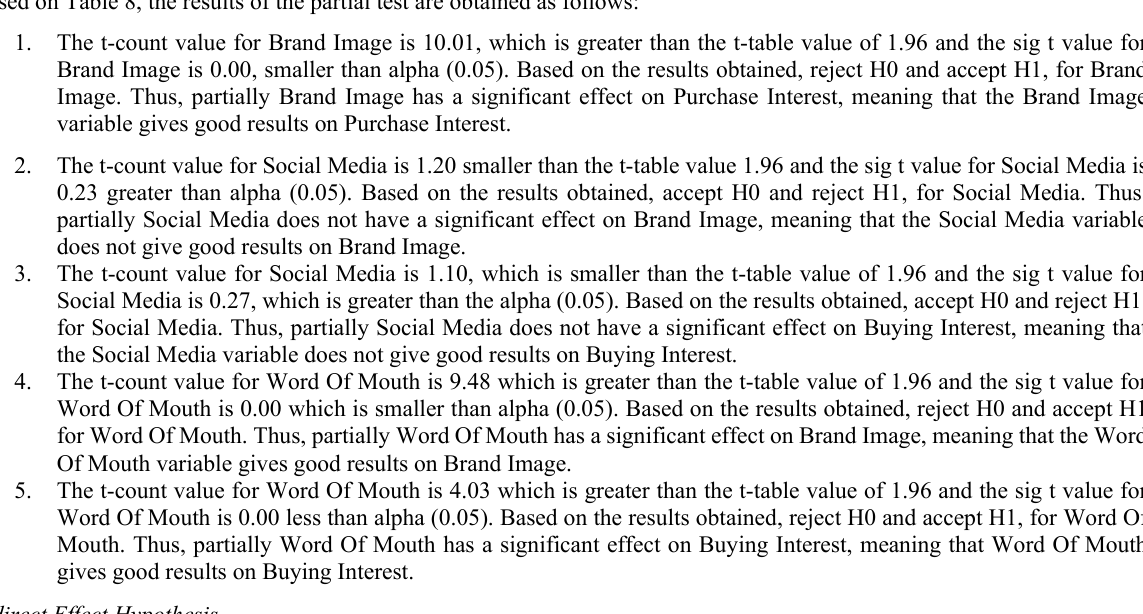
T-statistics and Indirect P-Values